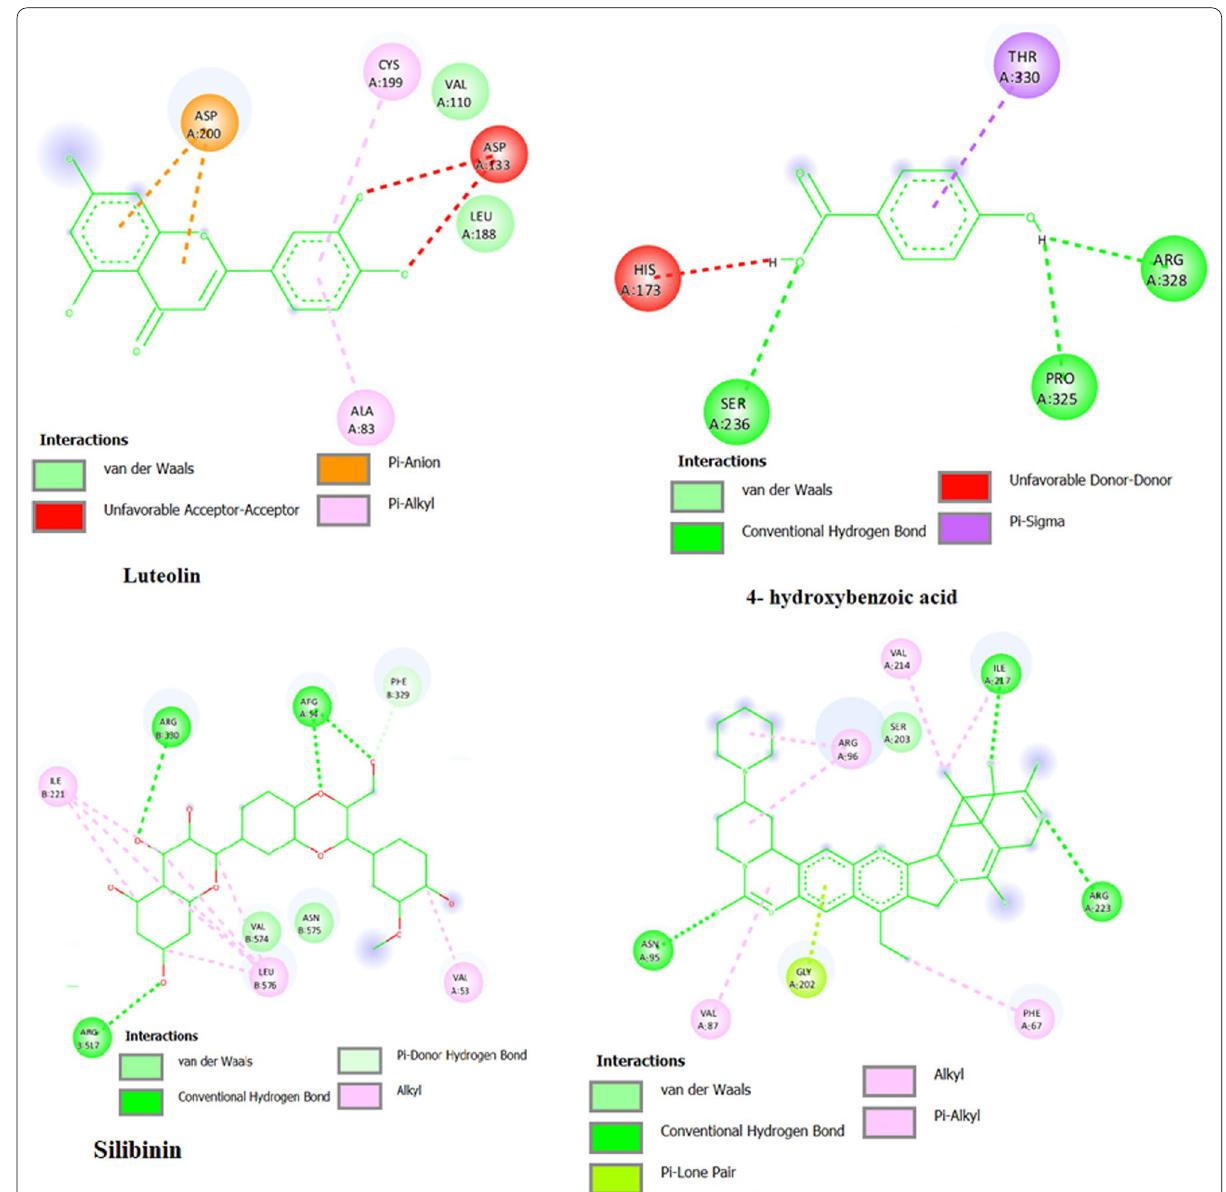
Fig. 7 Binding affinities of GSK-3β protein with phytochemical structure using AutoDock Vina. The 2D structure of protein–ligand interactions is visualized using Discovery studio visualizer and the interactions are predicted based on binding energy (kcal/mol) and hydrogen